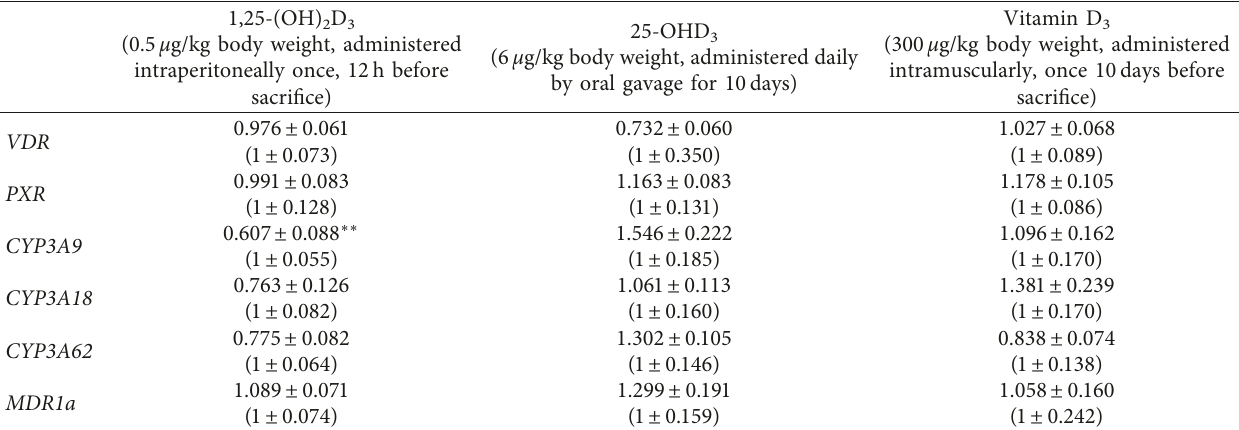
Means ± SEM of respective control groups set to 1 are given in brackets; asterisks indicate significant differences between treatment and control groups; ∗∗∗ P < 0 . 001. Table 4: RNA expression in the distal jejunum/ileum of rats treated with different vitamin D metabolites normalized to